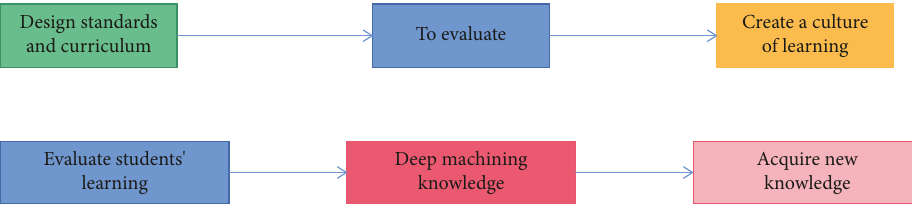
Figure 4: Deep learning